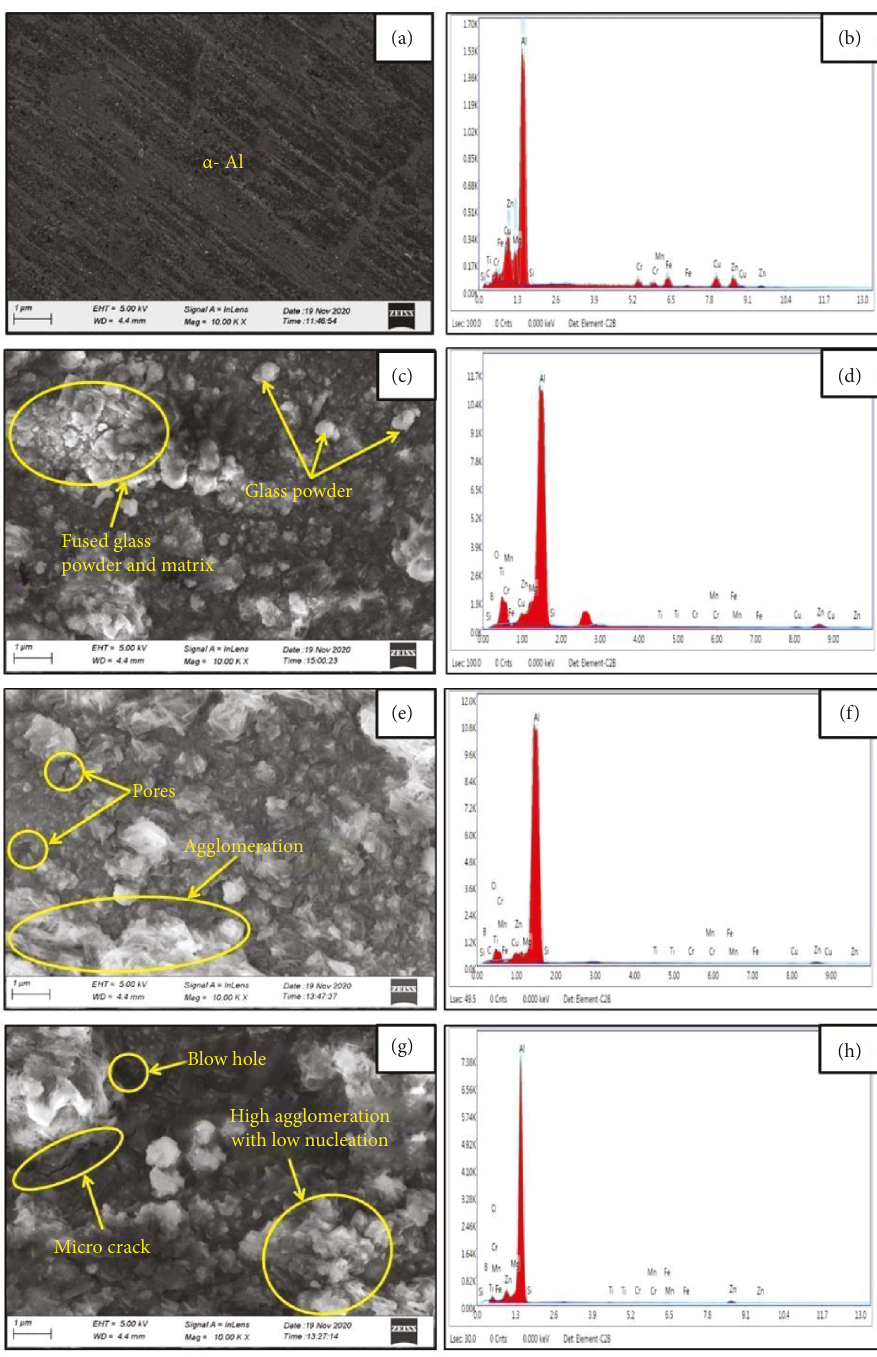
Figure 7: FESEM micrographs and EDX analysis of (a, b) AA7075alloy. (c, d) AA7075/3 wt. (%), (e, f) AA7075/6 wt. (%), and (g, h) AA7075/9 wt. (%) borosilicate glass